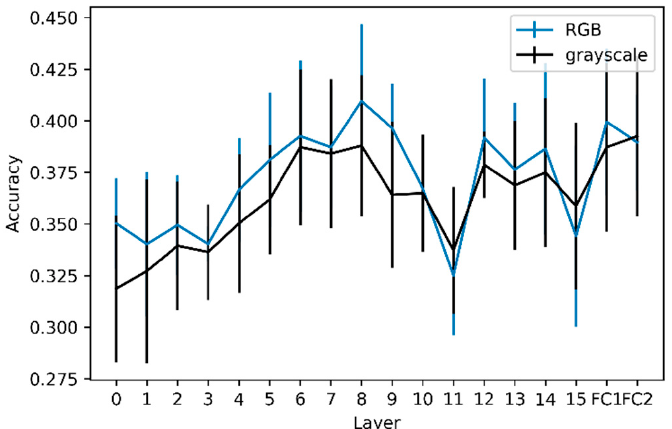
Figure 4. Mean accuracy of the 10-fold cross-validation for RGB images and grayscale images for each layer. The integer values on the x axis represent the convolutional layer on which the accuracy has been calculated, while FC1 and FC2, respectively, represent the first and second fully connected layers. The vertical bars represent the standard deviations.